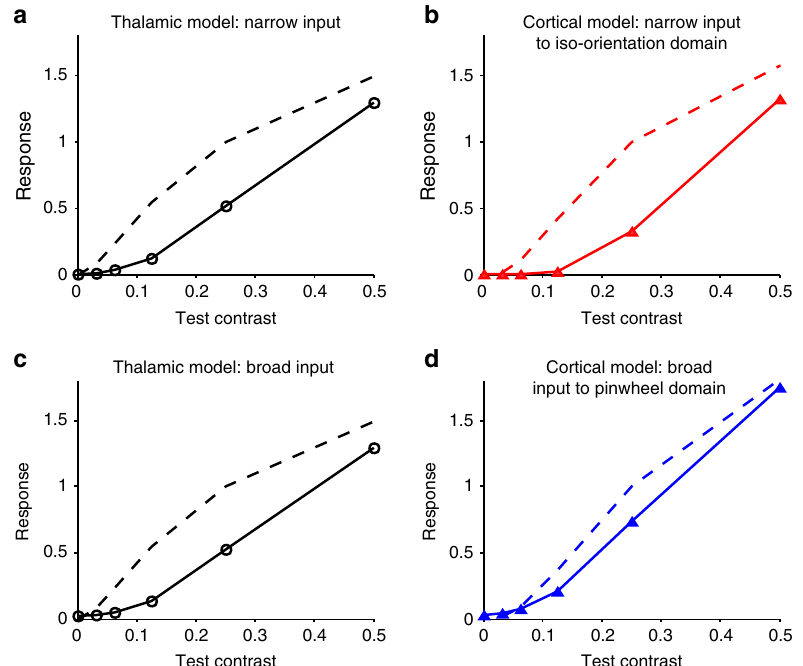
Figure 7 | EN model prediction for plaids with varying component contrasts. Predicted responses for ( a ) the thalamic model with narrow input to cortex, ( b ) the EN model with narrow input to an iso-orientation domain, ( c ) the thalamic model with broad input to the cortex and ( d ) the EN model with broad input to a pinwheel centre. Dashed curves are the contrast response curves measured through variation of the contrast of the preferred oriented single grating. Responses are normalized to the 25% contrast model output. The solid lines depict the model predictions for plaids where the preferred orientation is fixed at 25% contrast and the contrast of the component (test) orientation is